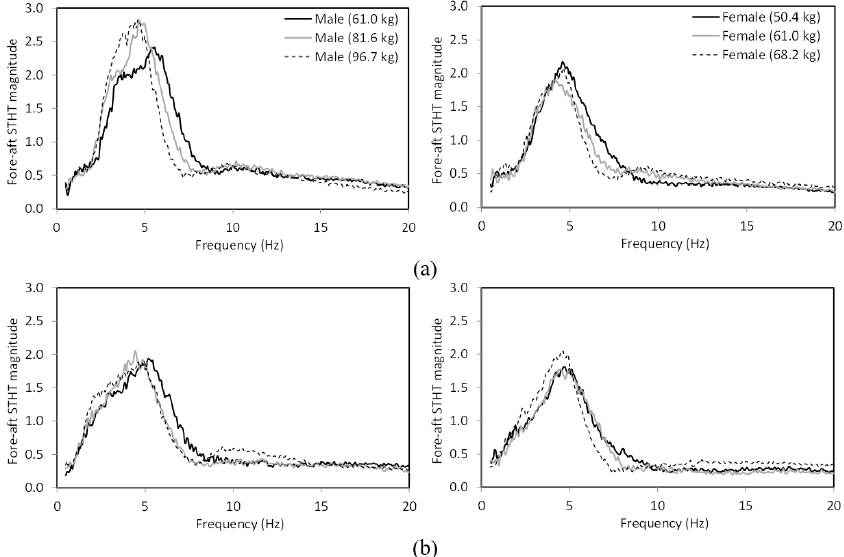
Figure 8. Mean fore-aft STHT magnitude responses of males and females within three different mass groups: ( a ) without back support; and ( b ) with back support (excitation: 0.50 m/s 2 ).